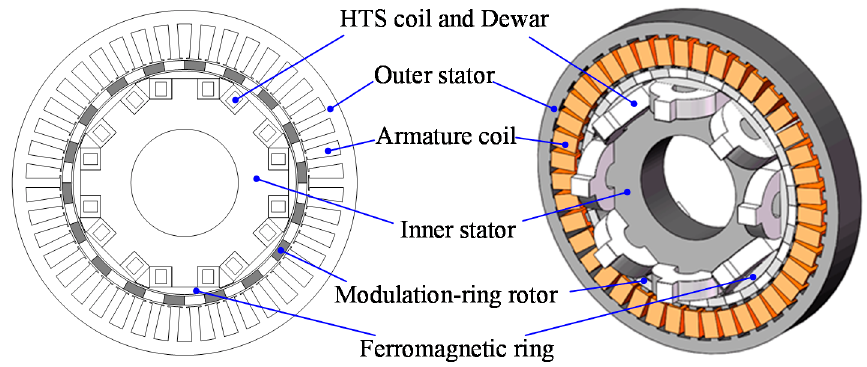
Figure 1. Configurations of the HTS-FMDS machine.